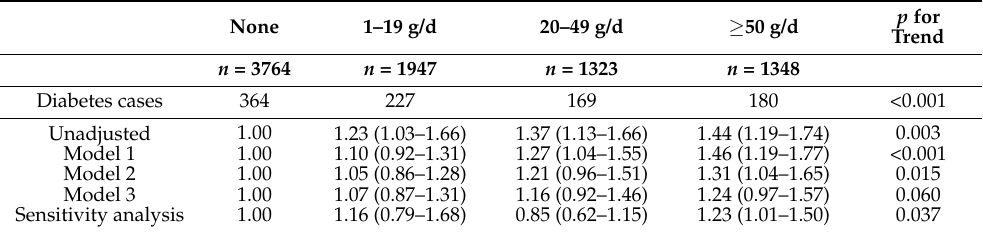
Table 3. Odds ratio (95% CI) for diabetes by cumulative ultra-processed food intake among partici- pants attending China Health and Nutrition Survey in 2009 ( n = 8382).